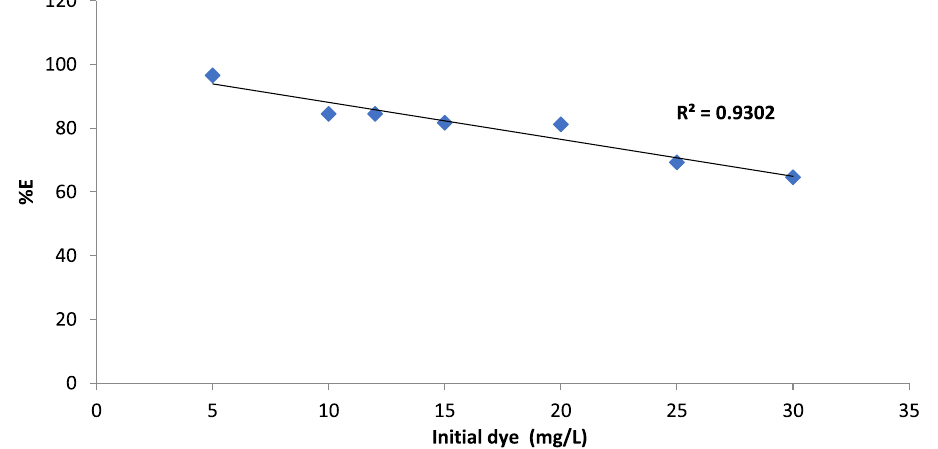
Figure 7. Influence of initial concentration on biosorptive removal of BF dye by Gel@GO-F-ZrSiO 4 @Gel.